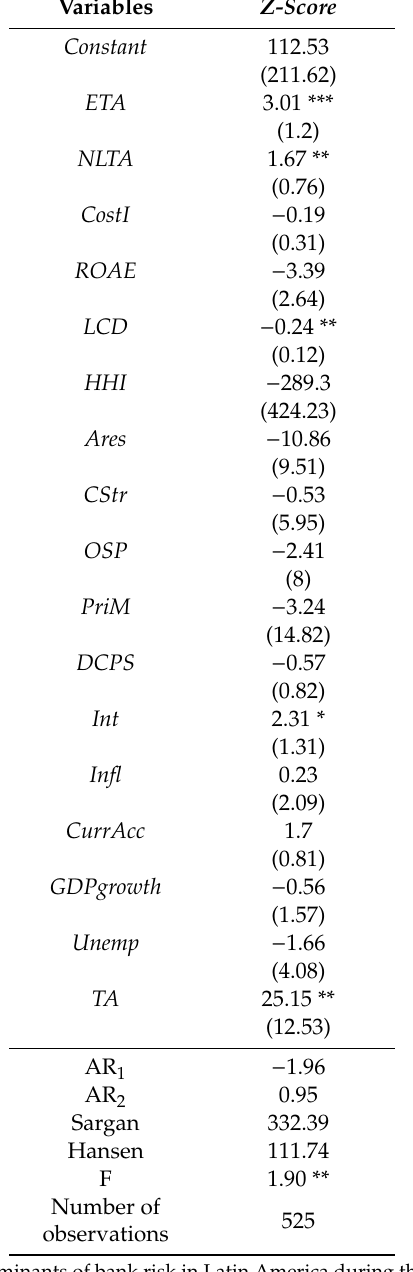
Table 3. System-GMM estimators of the Z-score